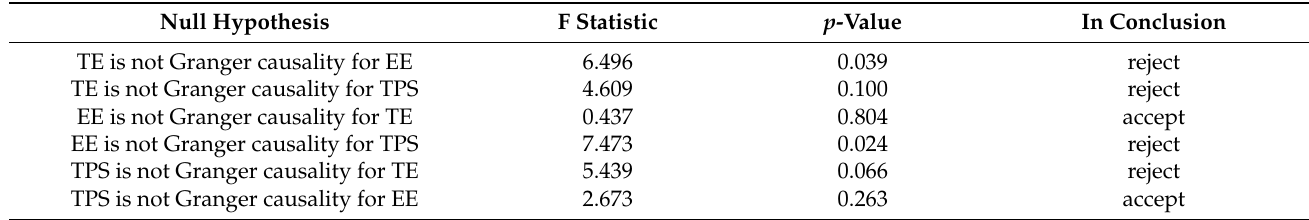
Table 10. Granger Causality Test